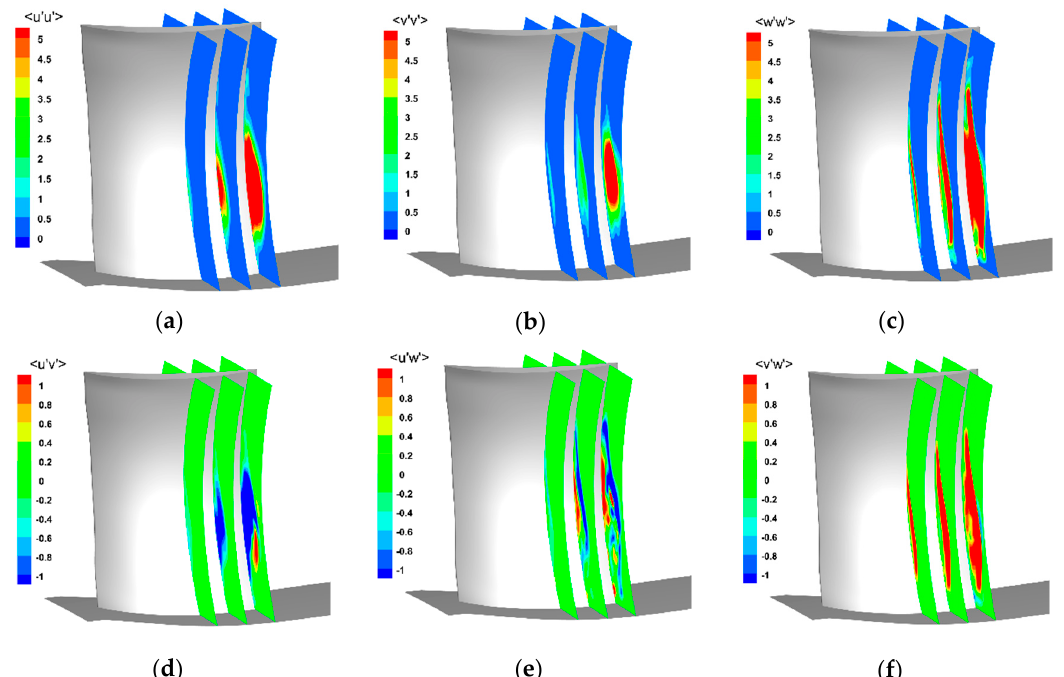
Figure 15. Reynolds stress throughout the blade passage: ( a ) <u’u’>; ( b ) <v’v’>; ( c ) <w’w’>; ( d ) <u’v’>; ( e ) <u’w’>; ( f ) <v’w’>.